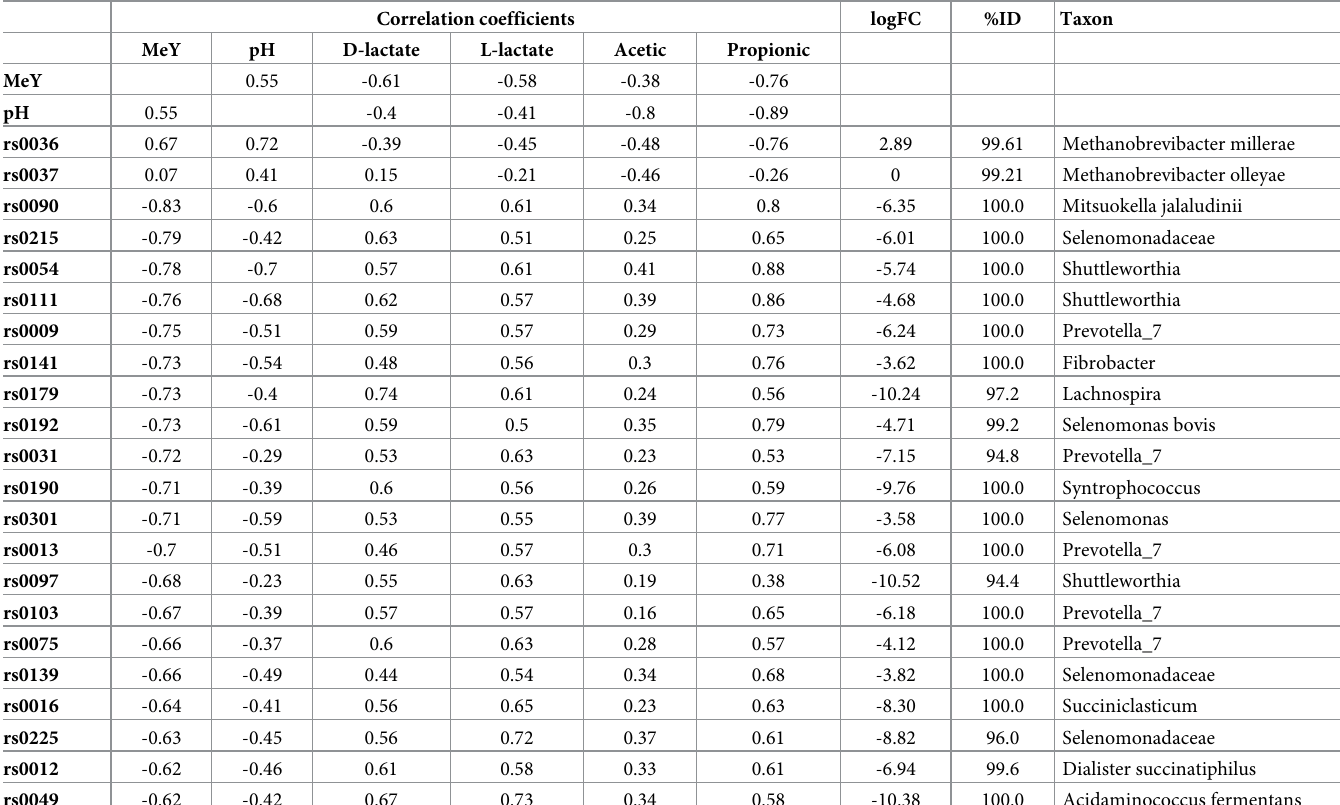
Table 3. Correlation of OTU vs ruminal MeY, pH and volatile fatty acids